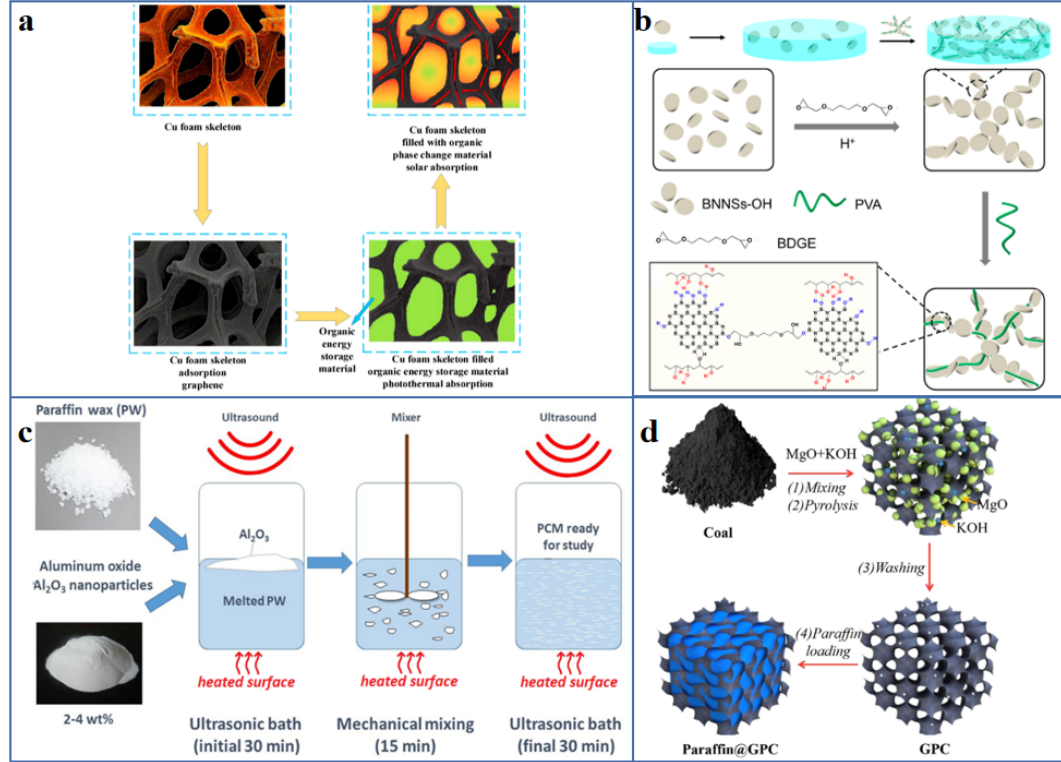
Figure 10. Schematic diagram of preparation of thermally enhanced composite PCM by introducing different types of thermally conductive fillers: ( a ) metals [152] (Copyright (2019) with permission from Elsevier Ltd.), ( b , c ) ceramics [153,154] (Copyright (2019) with permission from American Chemical Society. Copyright (2019) with permission from Elsevier Ltd.), ( d ) 3D porous frameworks [155] (Copyright (2019) with permission from Elsevier